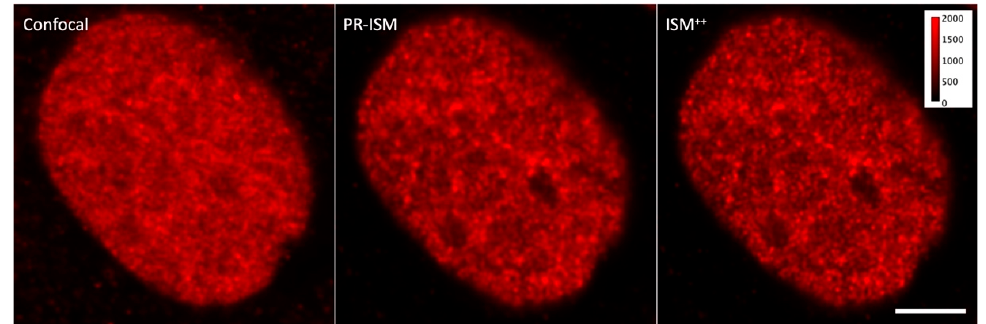
Figure 2. Confocal, PR-ISM, and ISM ++ images of an HCC827 nuclei immunolabeled by RING1b. All images were rescaled to the same digital level interval (0–2000) for better comparison. Scale bar: 10 µm.